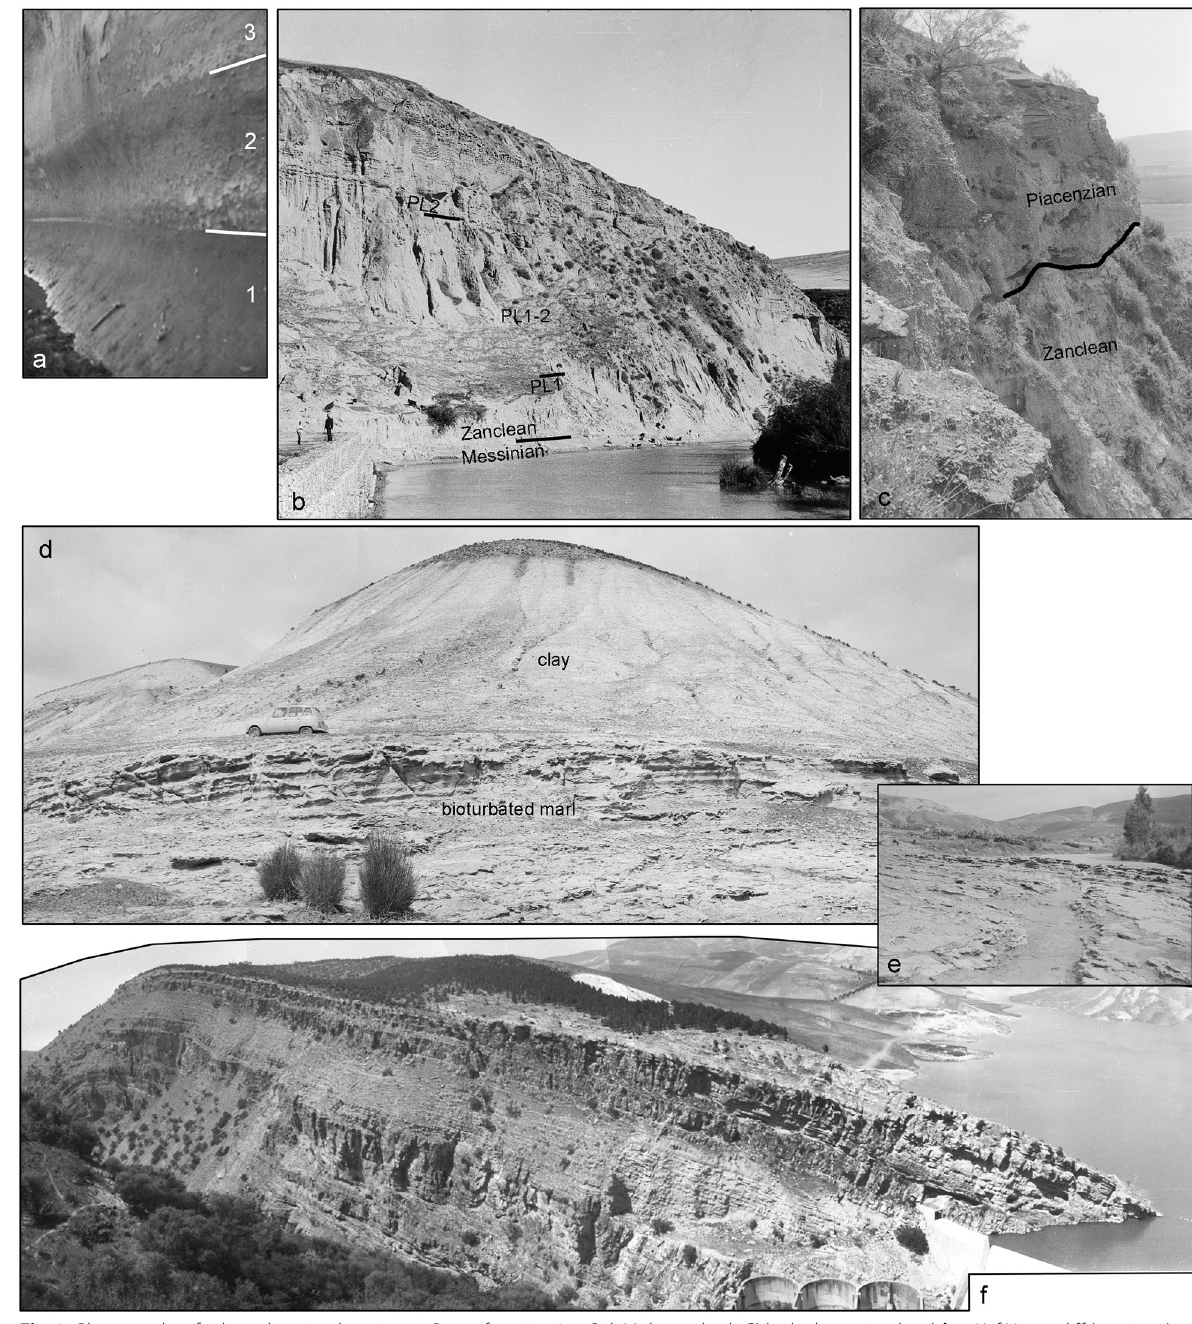
Fig. 3 Photographs of selected section locations. a Base of section 2 at Sidi Mohamed ech Chleuh above river level. b , c Kef Nsour cliff (section 4); b panoramic view; c view of cliff top with Piacenzian sediments exposed. d , e Tortonian outcrop sequence near Sidi bou Sensal (section 7, and section 6 to the left in d ); d panoramic view; e eroded basal Tortonian bioturbated mudstones at section 7 in the Oued Beth river bed; f panoramic view of upthrusted Jurassic rocks of the Jebel Kansera along the Oued Beth